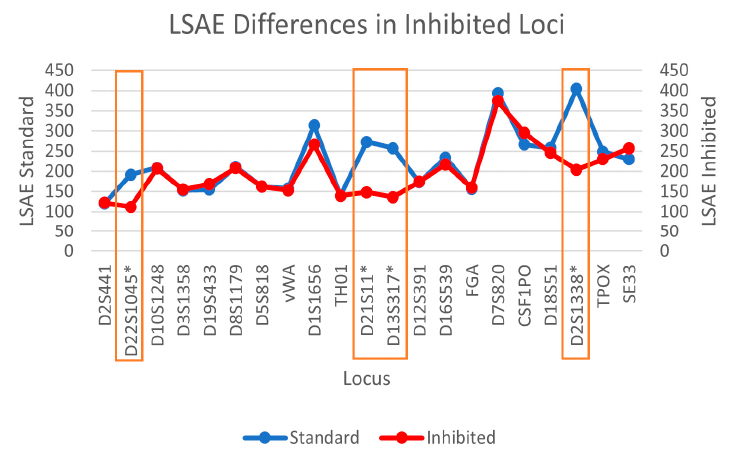
Figure 8. DSCS (3 cell subsample) decrease in locus specific amplification efficiency at inhibited loci (boxed and asterisked).